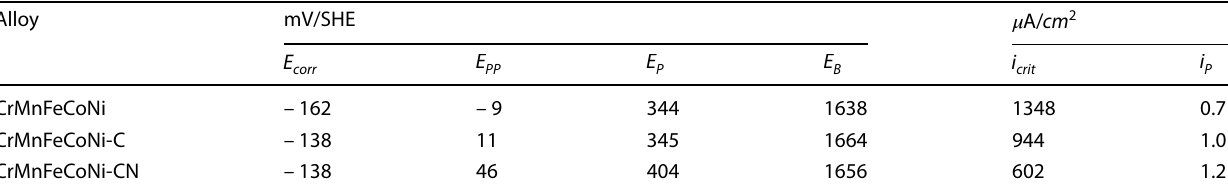
Table 6 Electrochemical corrosion test results in H 2 SO 4 0.5M. E corr : Corrosion potential. E PP : primary passivation potential. E P : potential at the begging of the stable passive region. E B : breakdown poten-